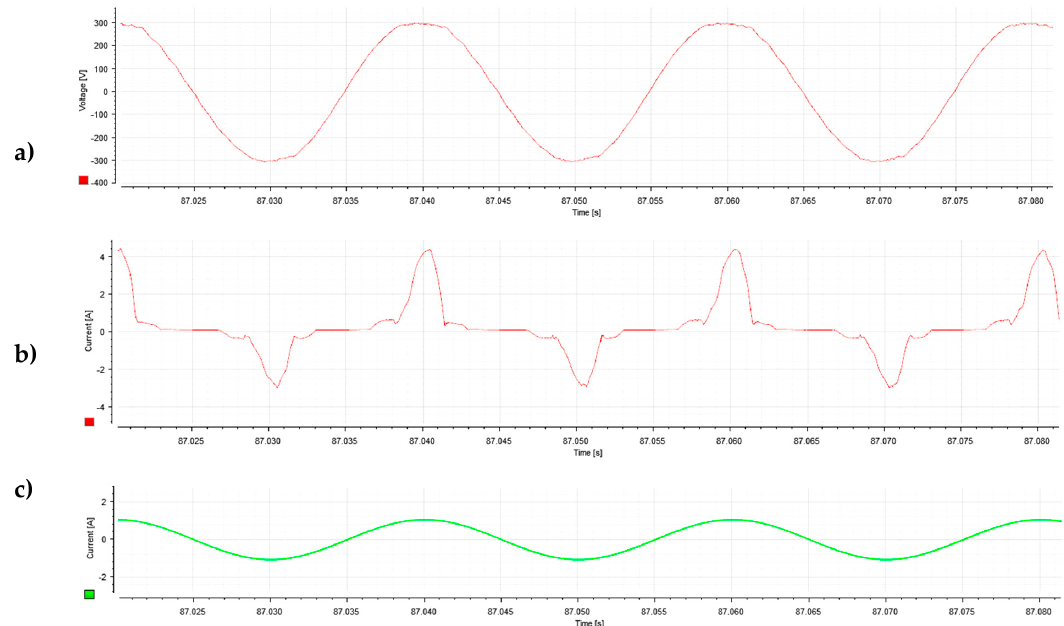
Figure 18. VSI output voltage and asymmetrical current waveforms drawn by the nonlinear DBR load used to obtain the VSI results. ( a ) Output voltage, v o ( t ); ( b ) asymmetrical nonlinear current; ( c ) fundamental component i OF extracted by the DSOGI.